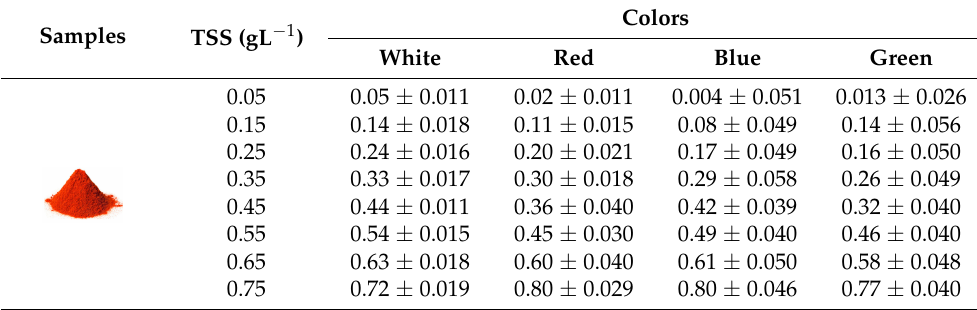
Table 8. The estimated TSS of the extra concentration samples with the proposed method. It shows mean values ± standard deviation of the TSS estimated by the CNN and the MLR for each color dataset for paprika